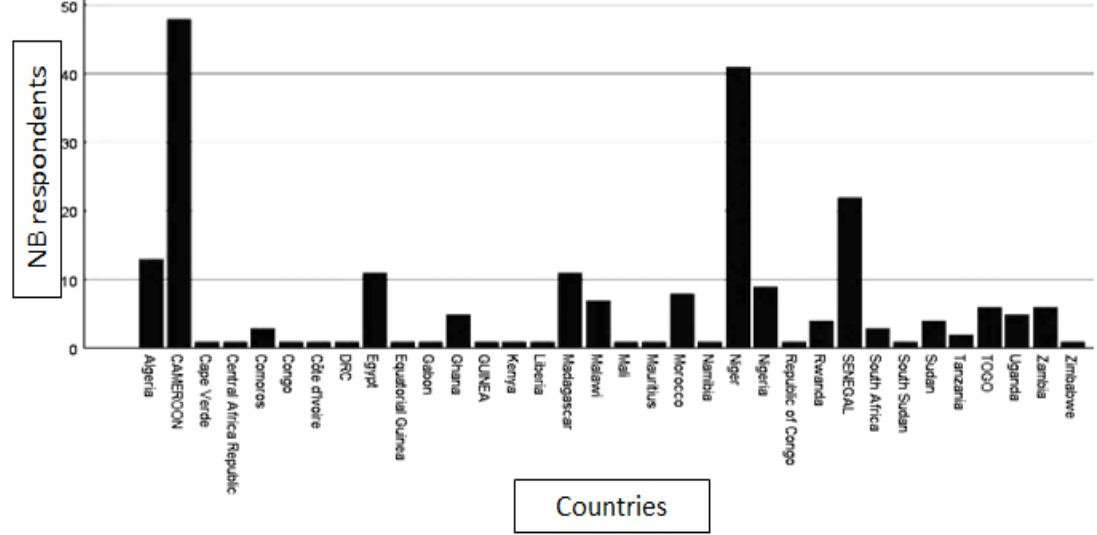
Fig. 1: The number of respondents in each country